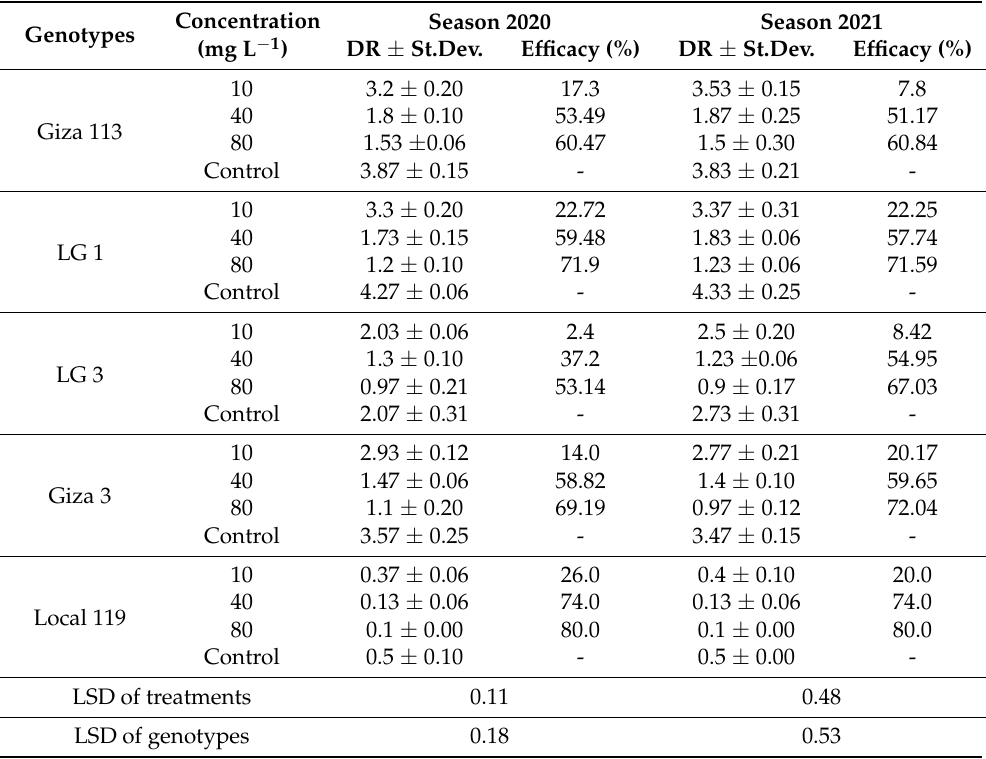
Table 4. Effect of Fe 3 O 4 /HA NPs on acremonium wilt of grain sorghum during seasons 2020 and 2021.